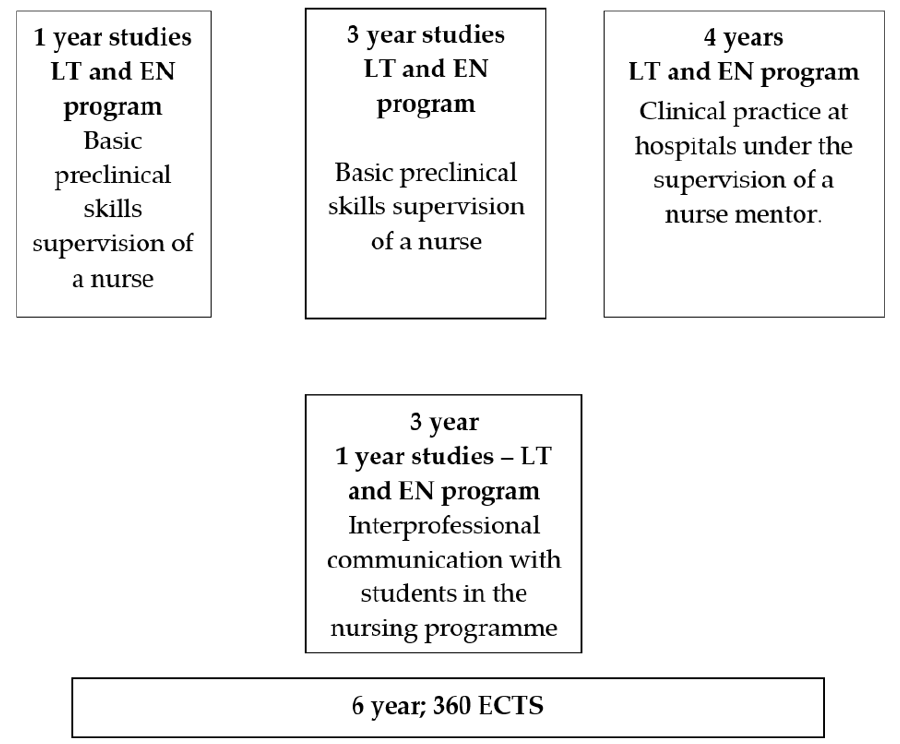
Figure 1. Medical program curriculum structure.